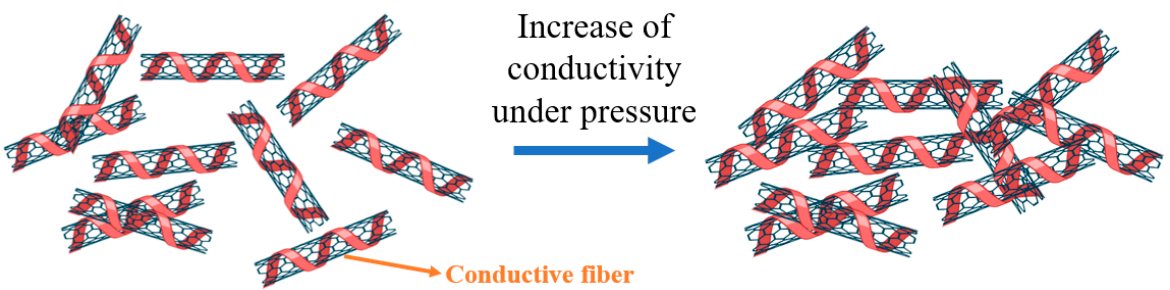
Figure 5. ( a ) Testing machine system, ( b ) piezoresistive textile sensors, ( c ) electrical properties.